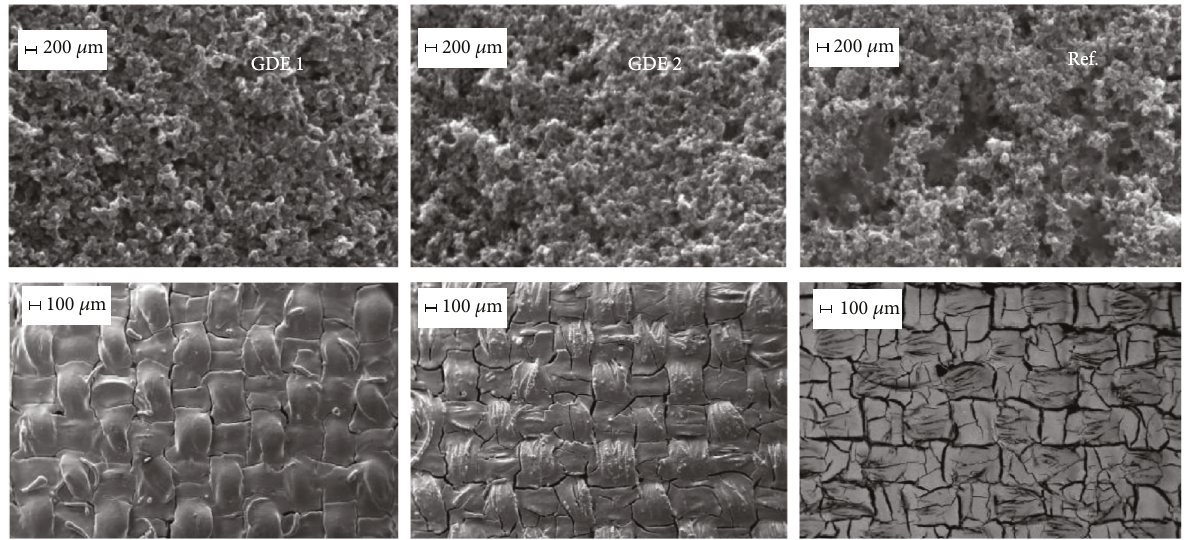
Figure 2: SEM micrographs of GDE1, GDE2, and Ref. at di ff erent magni fi cations.